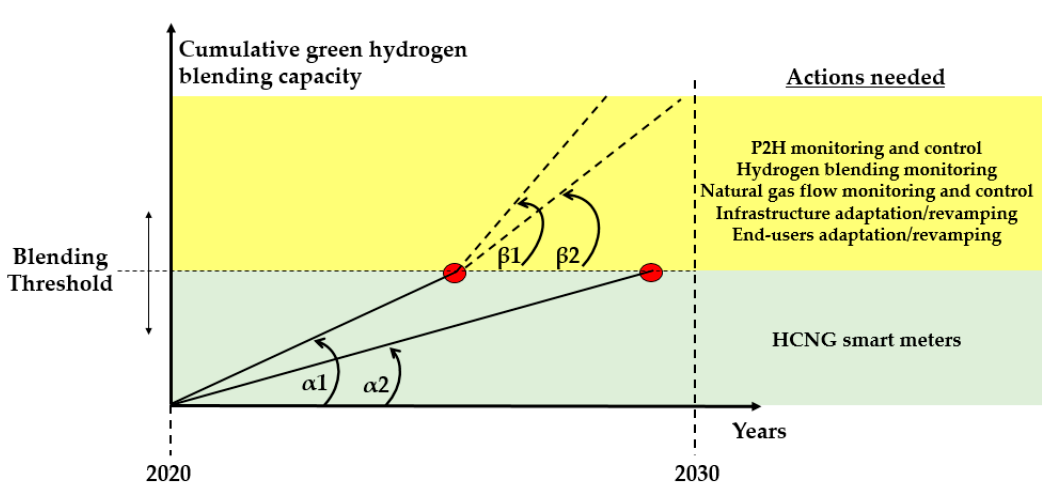
Figure 2. Natural gas flowrate variation respect to the daily average flowrate. Original elaboration based on data from [46].